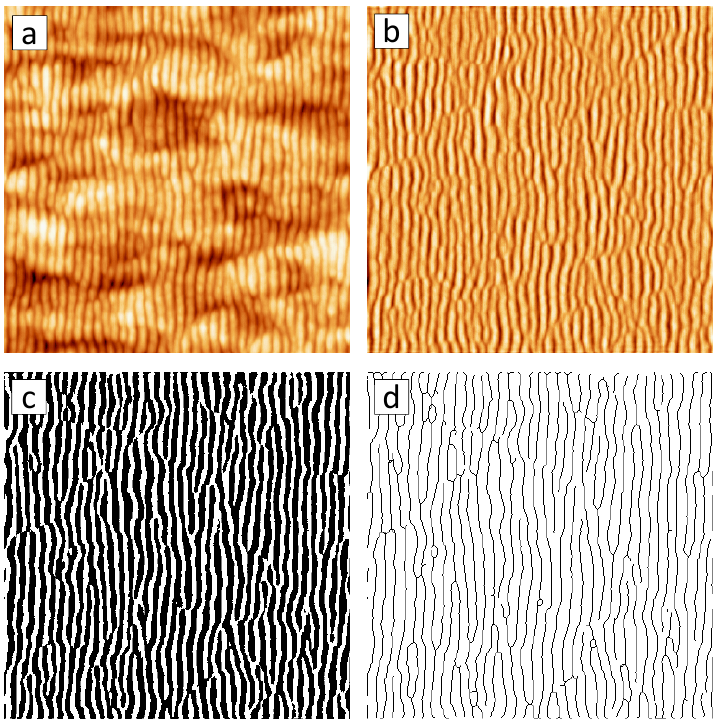
Figure 11. AFM image (a) after Fourier-filtering (b), conversion into a binary image (c) and thinning the ripples to single pixel lines (d). The size of the images is 1 × 1 µ m 2